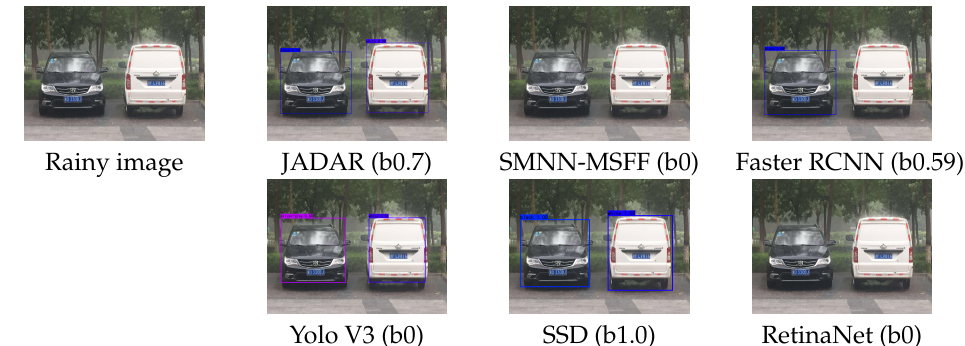
Figure 11. Test results of JADAR and color recognition and object detection methods on the RID.